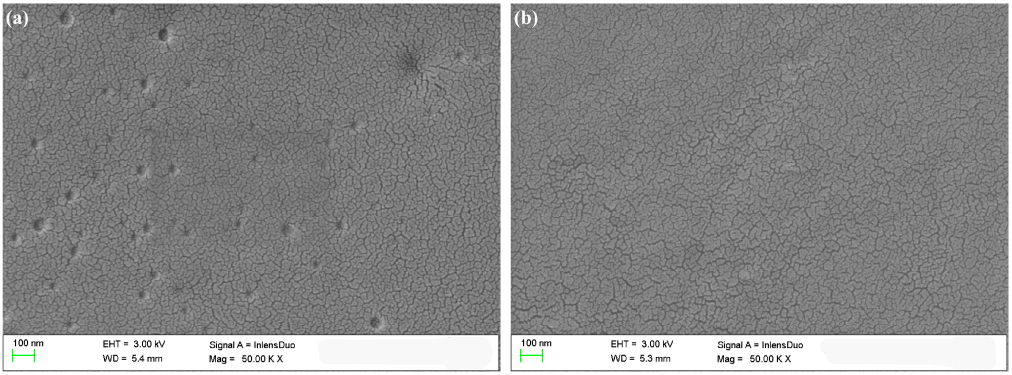
Figure 3. SEM images of the polymer films with magnification of 50000: (a) P(TBT-TBTh); (b) P(TBT-F-TBTh).